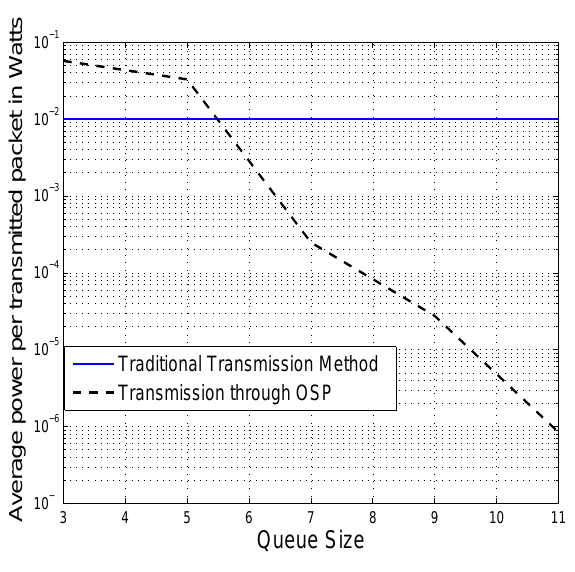
Figure 5. Power Saving through OSP for N=5.